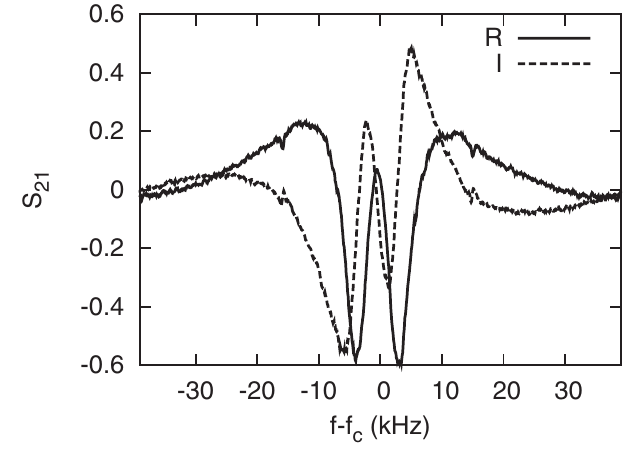
FIG. 4. Longitudinal beam transfer function near 5.2 GHz.